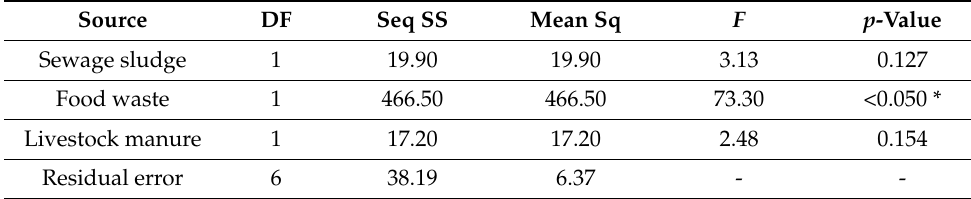
Table 10. Analysis of variance for volatile solids (VS)